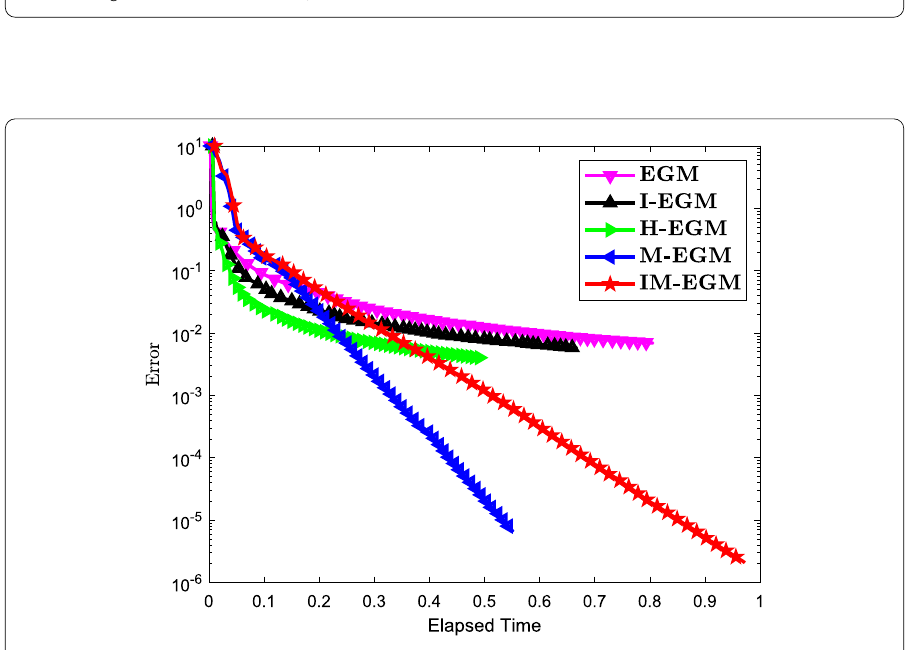
Figure 16 Numerical comparison of Algorithm 1 and Algorithm 2 using Algorithm 1 in [52], Algorithm 2 in [51], and Algorithm 1 in [18], while s 0 = s 1 = cos( t ) for the first 500 iterations